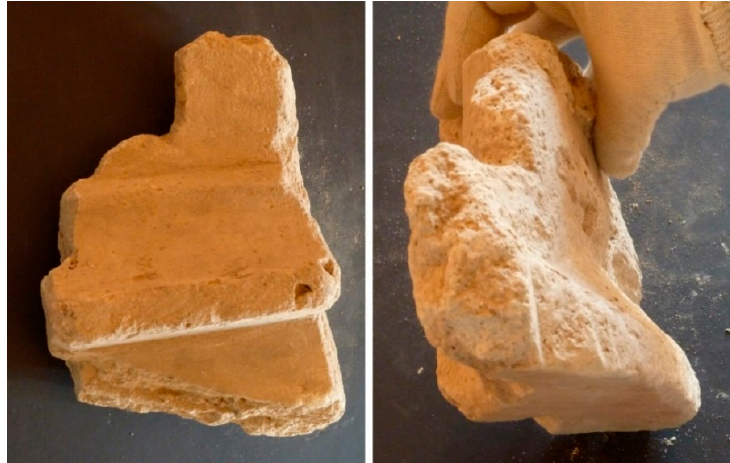
Figure 20. Arch fragment of the Molina de Aragón Synagogue, ( left ) view of the intrados side, ( right ) the special form to be embedded from the top of the piece. Author’s photo.